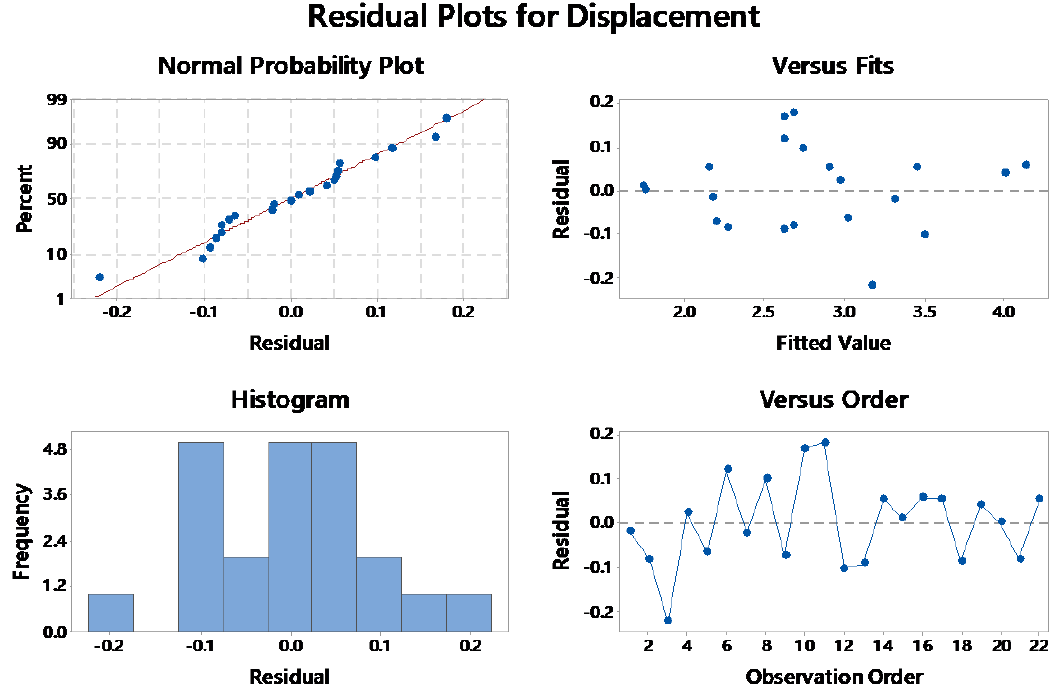
Figure 2. The residual plots for the displacements of sample point H.